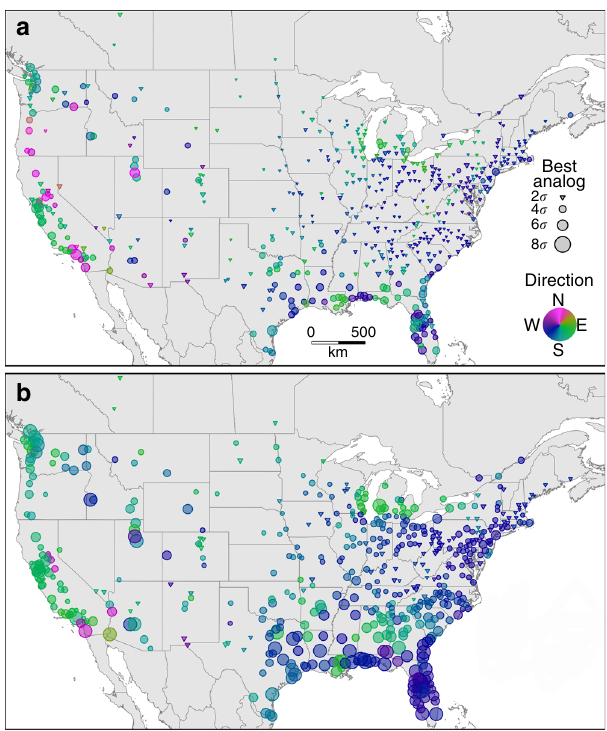
Fig. 3 Strength of analogy for contemporary climatic analogs. Triangles indicate urban areas with representative contemporary analogs (<2 σ ); circles indicate increasingly poor analogs, with size of symbols scaled to sigma dissimilarity for the ensemble mean of the 27 projections under a RCP4.5 and b RCP8.5. Shading indicates the initial bearing from each